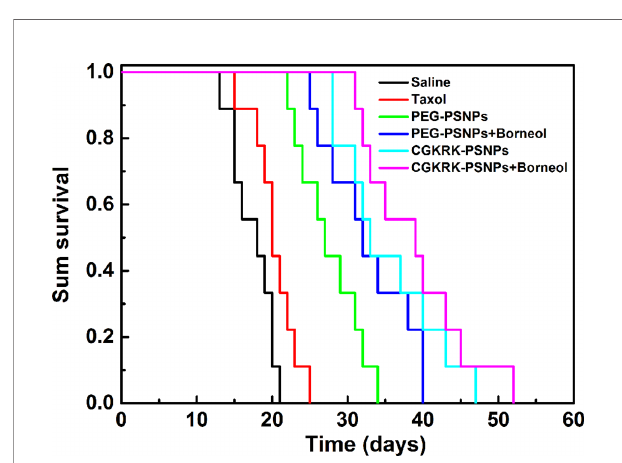
FIGURE 9 | Kaplan-Meier survival curve of U87MG glioma-bearing mice treated with different PTX formulations at a dose of 10mg/kg PTX on day 2, 4, 6, and 8 post implantation (n =